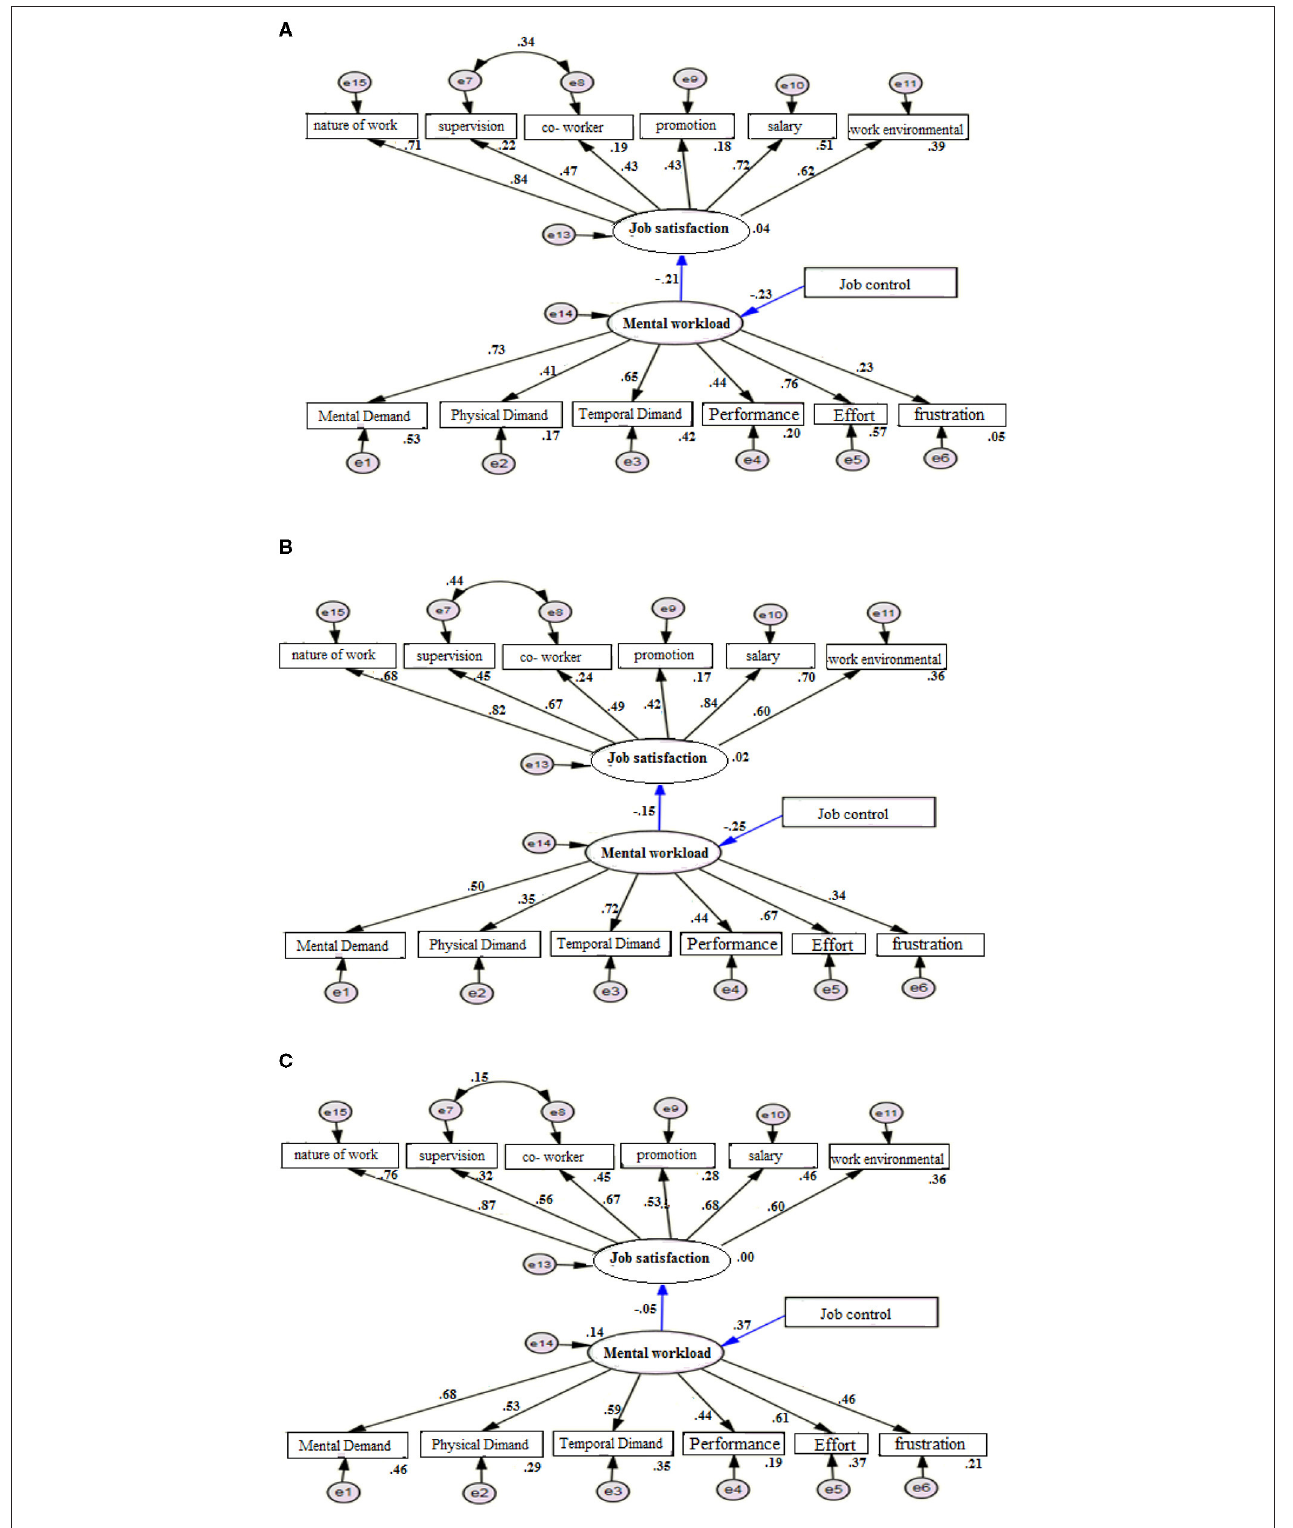
FIGURE 3 | The model of relationship between variables of divided occupational groups; (A) nurses, (B) midwives, and (C) administrative staff.